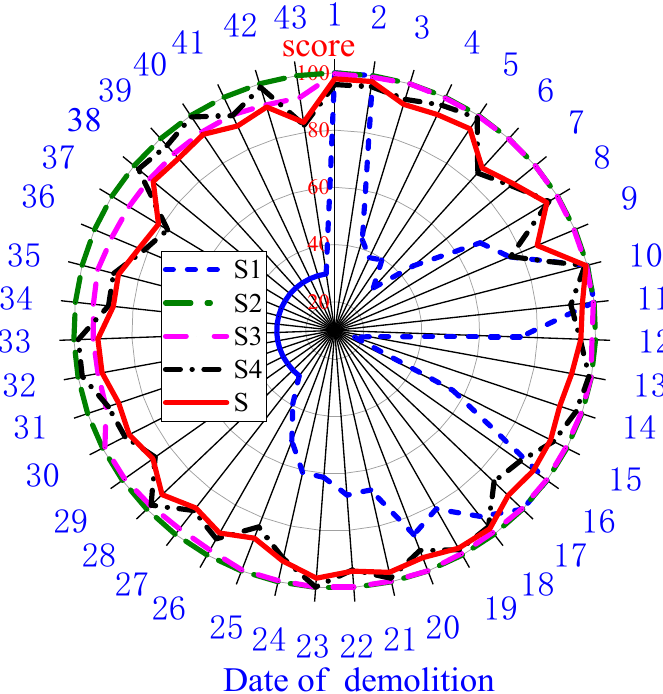
Figure 16. Assessment results during the demolish construction.